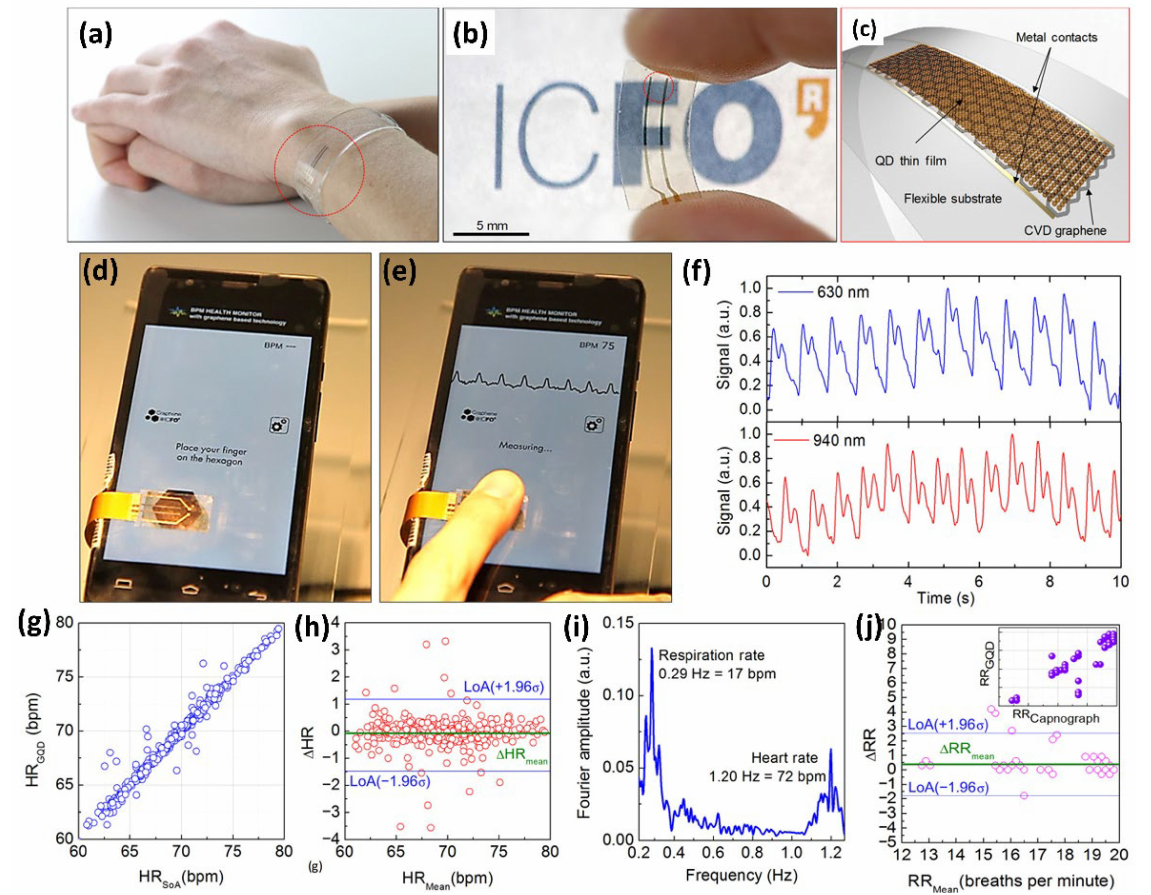
Figure 10. ( a ) Illustration of transparent and flexible GQD photodetector implanted in an HR tracking wristband. ( b ) A zoomed-in view of stretchable photodetector on polyethylene naphthalate substrate with a 1 mm 2 graphene channel entirely encased in a thin 30 nm-thick coating of PbS QDs. ( c ) Schematic representation of graphene and QD setup on a flexible substrate assembly. Photodetection in graphene/PbS QD heterostructure-based health patches for wearable fitness via HR and RR monitoring: ( d , e ) a mobile-phone screen with an adaptable health patch. ( f ) Signals from photoplethysmography (PPG) at 630 and 940 nm. ( g ) Two simultaneous readings of a health patch and a cutting-edge PPG sensor. ( h ) Bland–Altman assessment of the patch ( i ) Fourier transforms of PPG’s. ( j ) Bland–Altman evaluation of the obtained RR. Adapted with permission from Ref. [145]. Copyright 2019,